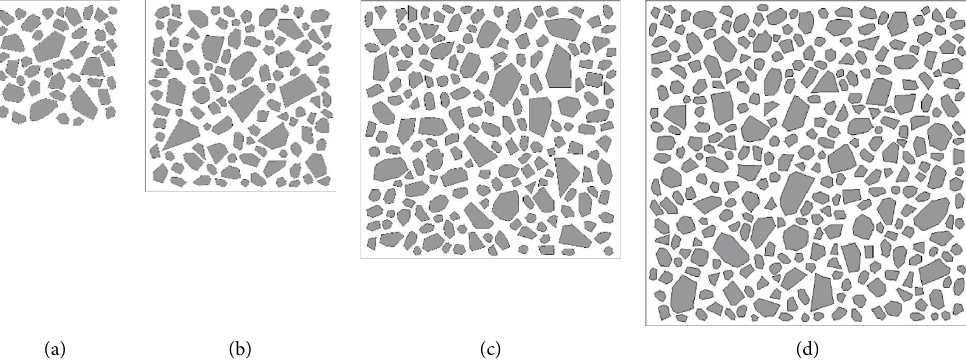
Figure 4: Random aggregate model with diferent sizes of specimens. (a) 100 × 100mm. (b) 150 × 150mm. (c) 200 × 200mm. (d) 250 × 250mm.